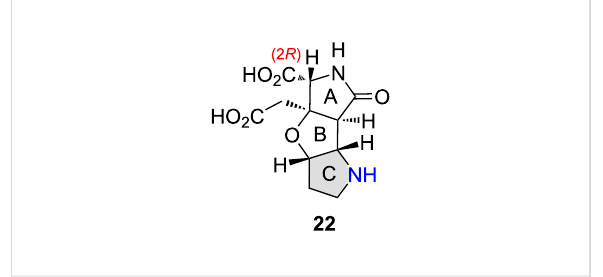
Figure 10: The future synthetic target 22 is expected to show potent